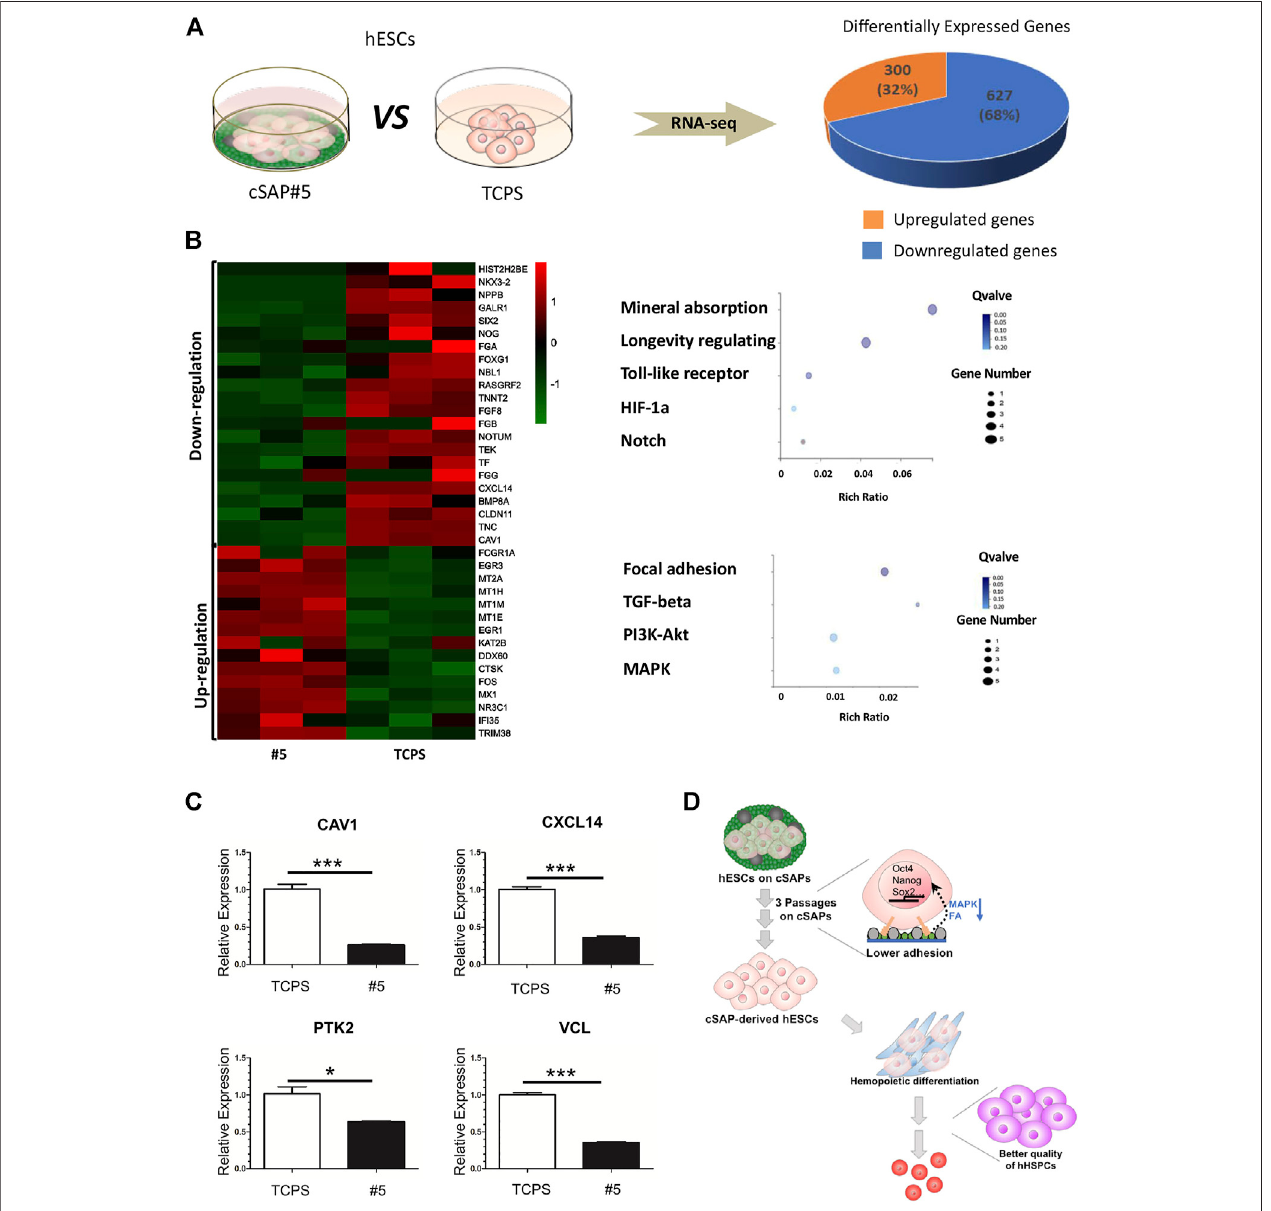
FIGURE6| Thetranscriptional pro fi leand qPCR analysisofcSAP-derived hESCs. (A) RNA-seq analysisoftranscriptional pro fi lingofcSAP #5-derived and TCPS- derivedhESCs; (B) Thedifferential expression genes(DEG)analysis. Theselectedgeneswere presented byheatmap, and theselected enriched pathwayswereshown by dot-plot. (C) qPCR results of CAV1, CXCL14, PTK2, and VCL expression after three passages ’ culture ( n (cid:1) 4). (D) Schematic illustration of the role of cSAP in the maintenance of pluripotency and the improvement of the hemopoietic potential of hPSCs.